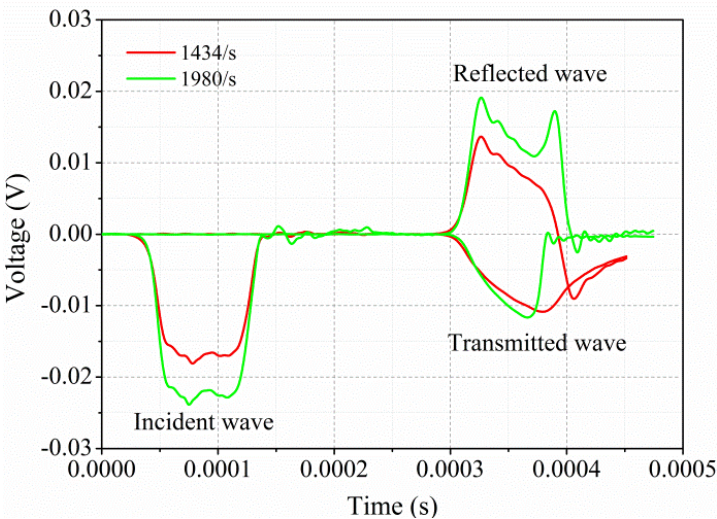
Figure 3. Original signals of incident, reflected, and transmitted waves recorded by strain gauges.